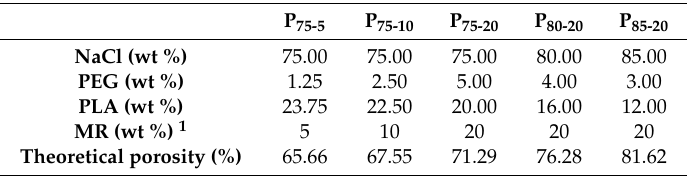
Table 1. Composition formulation and theoretical porosity of ternary blends of poly(lactic acid) (PLA)/poly(ethylene glycol) (PEG)/NaCl.